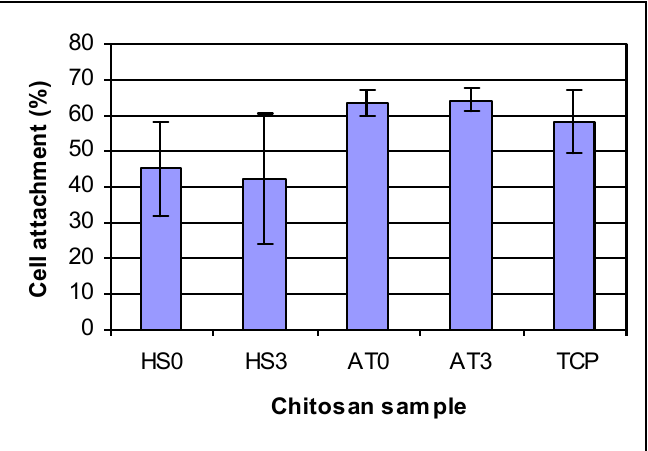
Figure 6. HEPM cell attachment on chitosan films for 4 h. For cell attachment: there are differences by ANOVA Groups that are the same: (1) HS0 and HS3; (2) HS0 and TCP; (3) TCP, AT0 and AT3. AT0 and AT3 are both significantly different from HS0 and